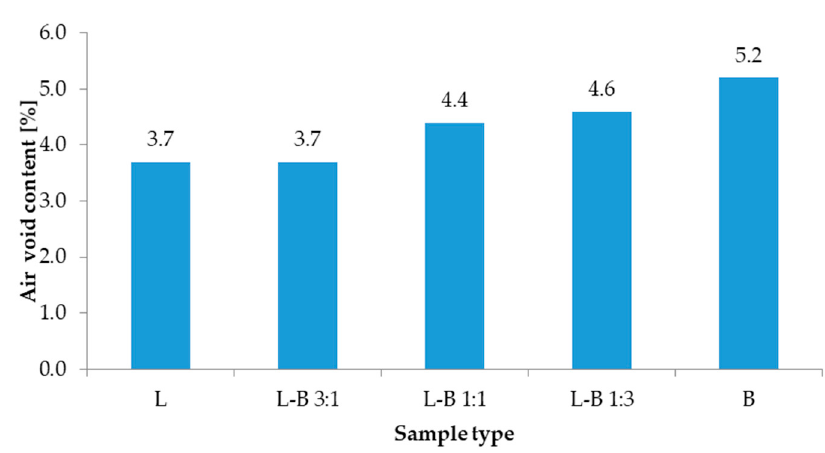
Figure 6. Maximum density and bulk density results of the studied mixes.